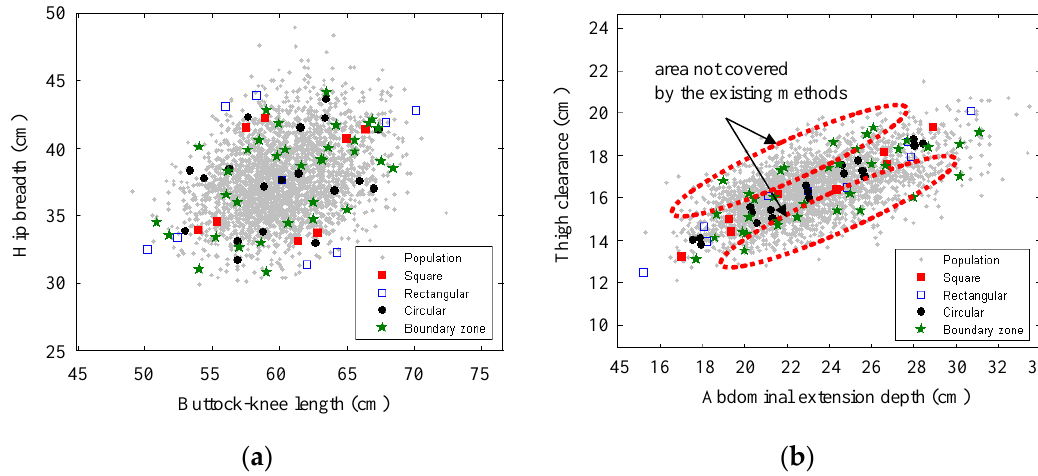
Figure 7. Distribution of the representative humanoids generated by the multivariate methods (illustrated). ( a ) Buttock–knee length vs. hip breadth, with a different factor loading pattern; ( b ) abdominal extension depth vs. thigh clearance, with a similar factor loading pattern.